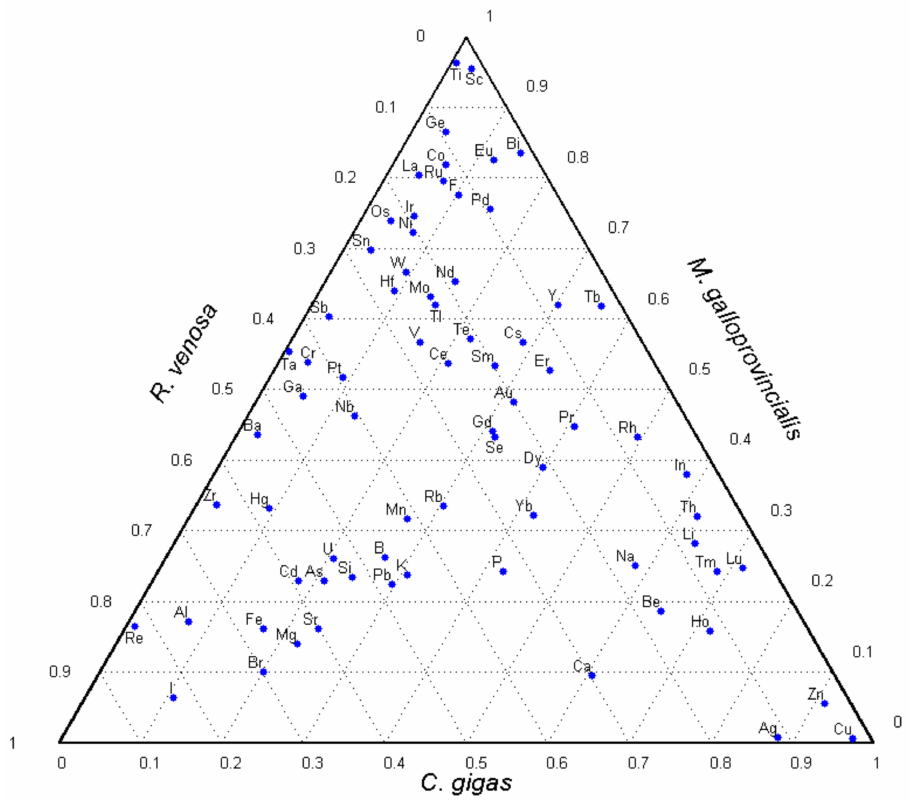
Figure 2. A ternary diagram of the element content fractions in soft tissues of the three